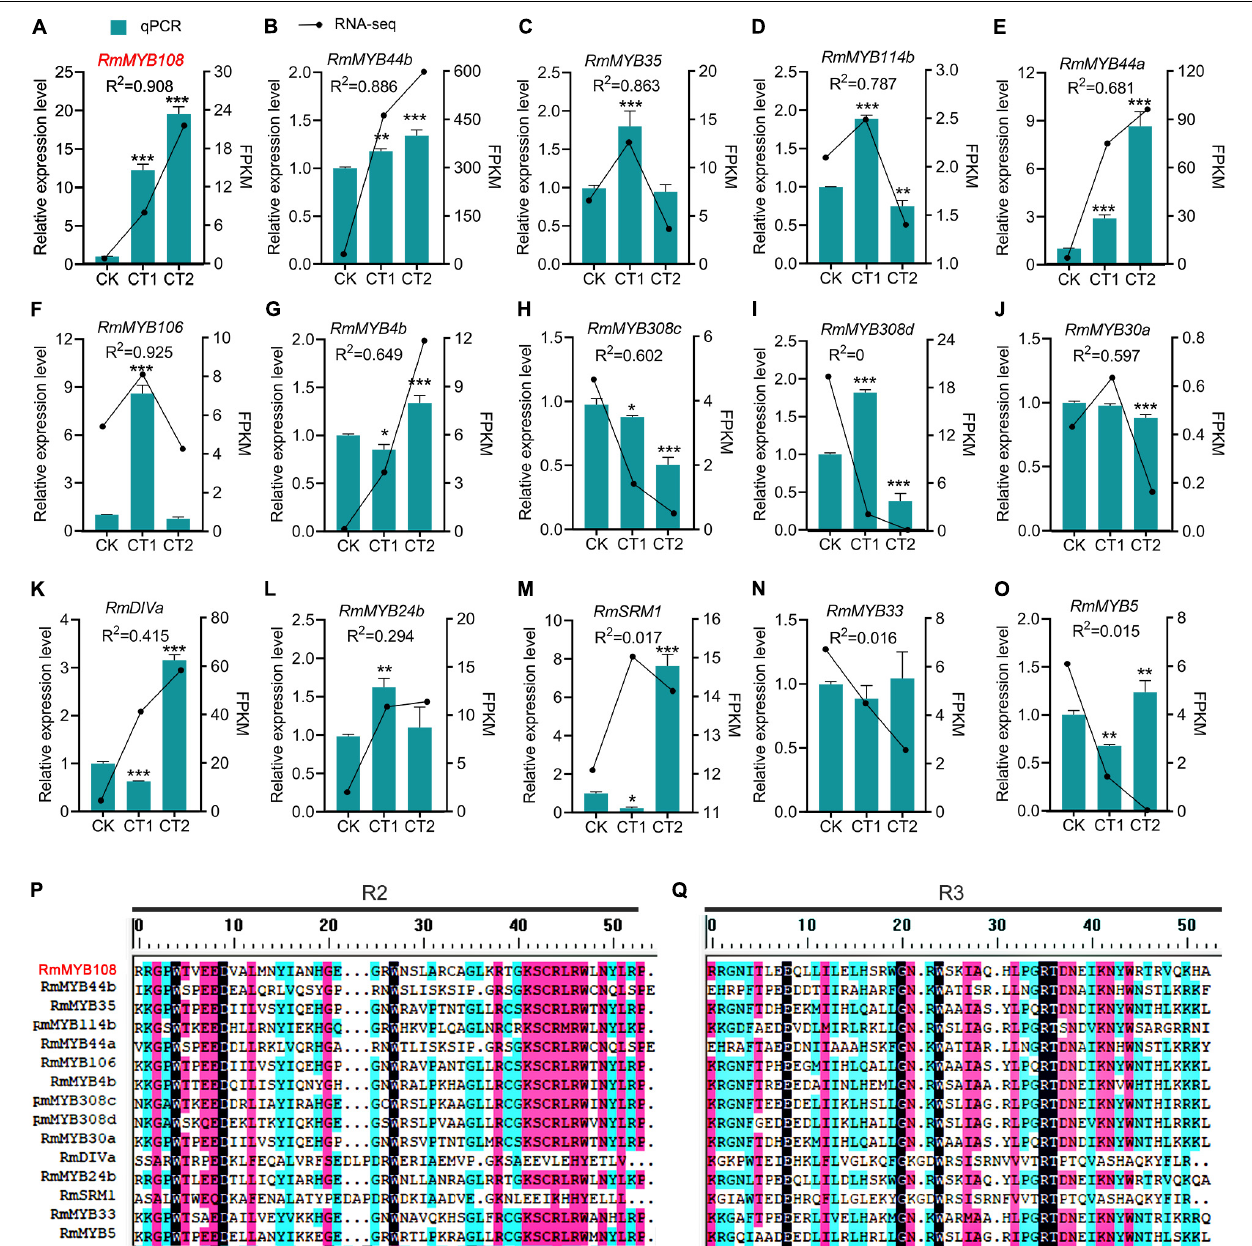
FIGURE 2 | R2R3-MYBs in R. multiflora respond to chilling stress.Relative expression level and fragments per kilobase per million (FPKM) of (A) RmMYB108 , (B) RmMYB44b , (C) RmMYB35 , (D) RmMYB114b , (E) RmMYB44a , (F) RmMYB106 , (G) RmMYB4b , (H) RmMYB308c , (I) RmMYB308d , (J) RmMYB30a , (K) RmDIVa , (L) RmMYB24b , (M) RmSRM1 , (N) RmMYB33 , (O) RmMYB5 under 25 ◦ C (CK), 4 ◦ C (CT1) and − 20 ◦ C (CT2). The correlation coefficient of each gene between FPKM from RNA-seq and relative expression level from quantitative real-time polymerase chain reaction (qRT-PCR) was represented by R 2 (coefficient of determination). * p < 0.05; ** p < 0.01; and *** p < 0.001 in statistics. The aligned sequences of both R2 (P) and R3 (Q) domains of 15 R2R3-MYB from R. multiflora were evolutionarily highly